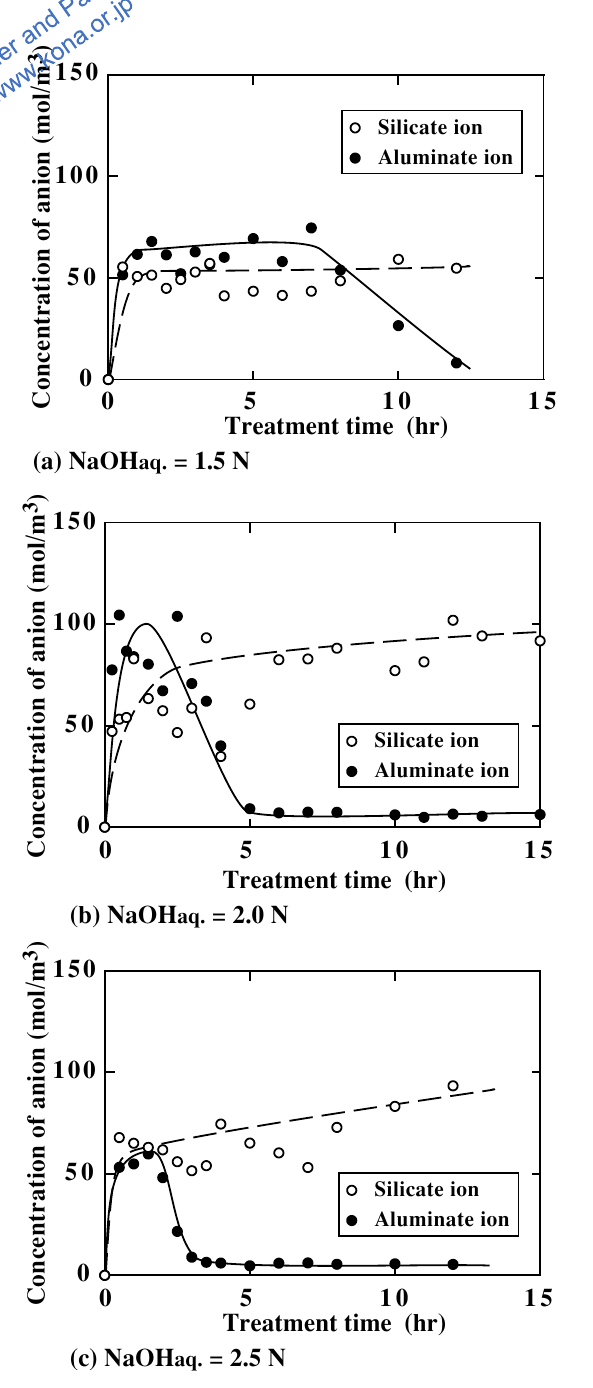
Fig. 6 Change in anion concentration in NaOHaq. with treatment time for various NaOHaq.concentrations.